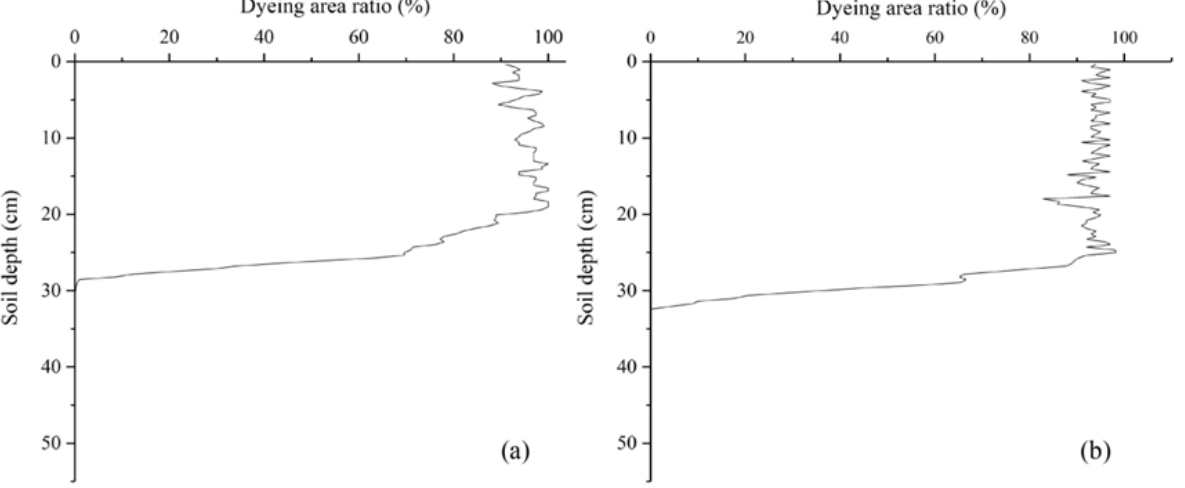
Figure 4. Distribution of dyeing area ratio. (a) is the dyeing area ratio result of the first dam section dyeing test, and (b) is the dyeing area ratio result of the second dam section dyeing test.